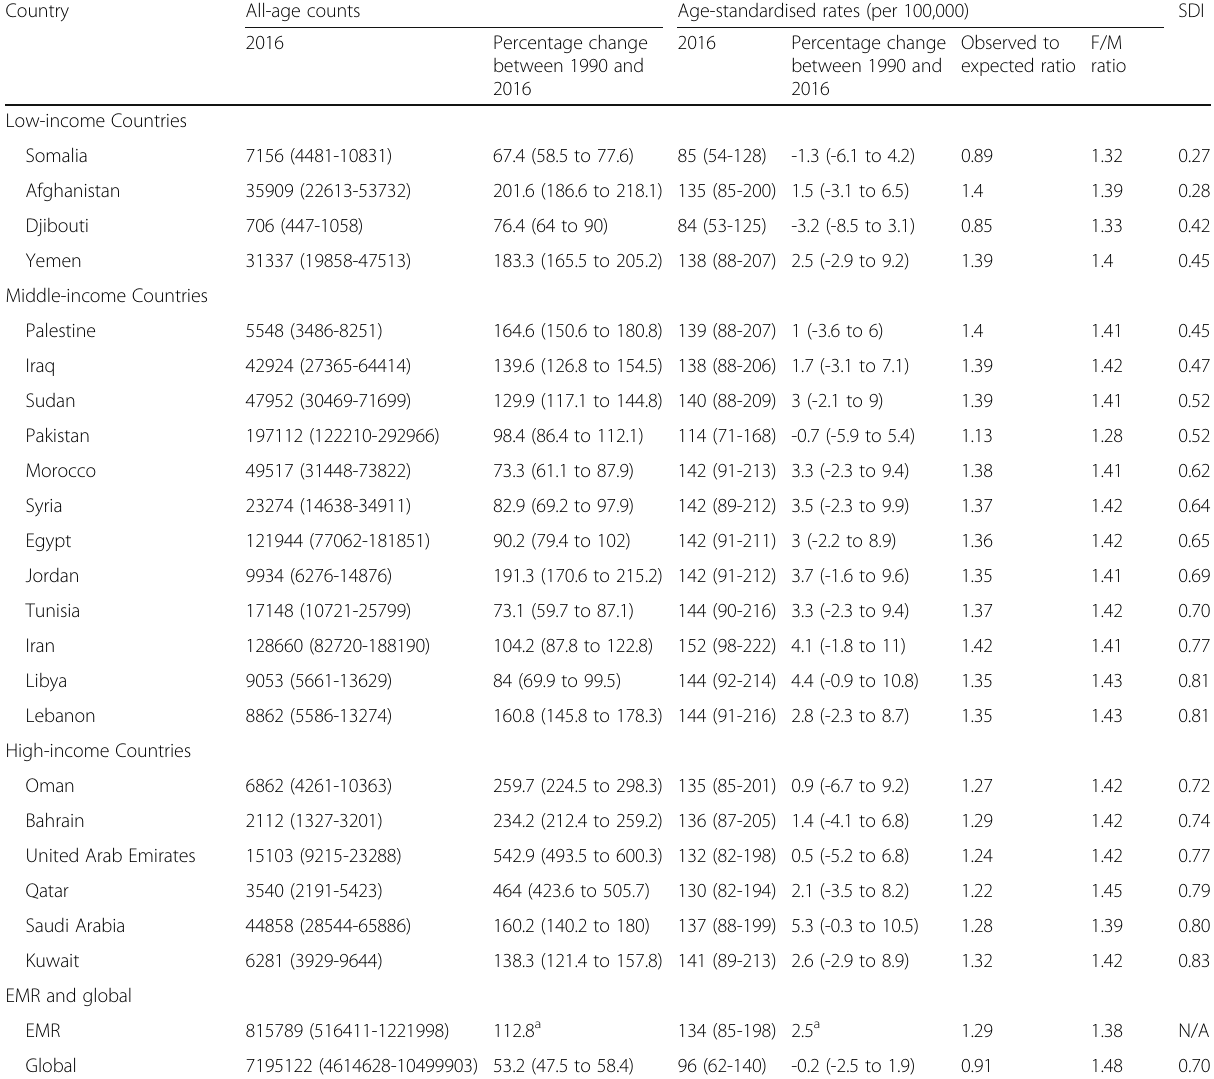
Table 4 YLD count, All-age YLD rates, and Age-standardised rates in 2016, and percentage change of YLD count, All-age YLD rates, and Age-standardised rates between 1990 and 2016 for TTH in EMR countries